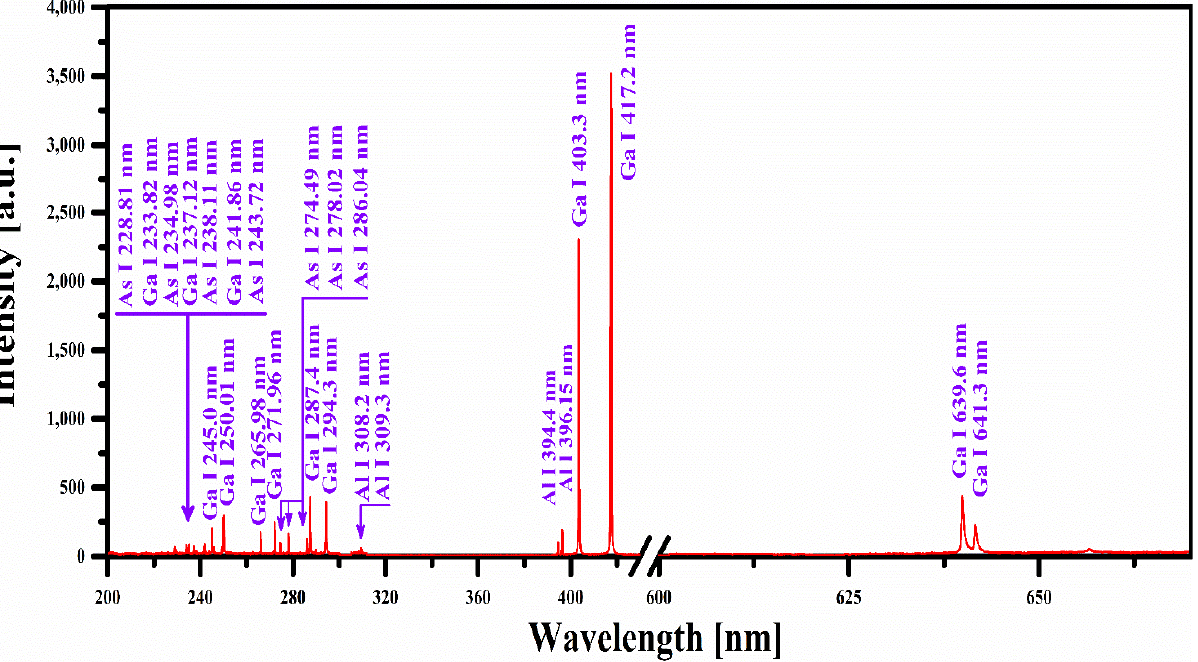
Figure 2. Optical emission spectrum of the AlGaAs sample covering the wavelength range from 200 nm to 670 nm. Table 2. Major emission lines detected in the wavelength region from 200 nm to 650 nm.